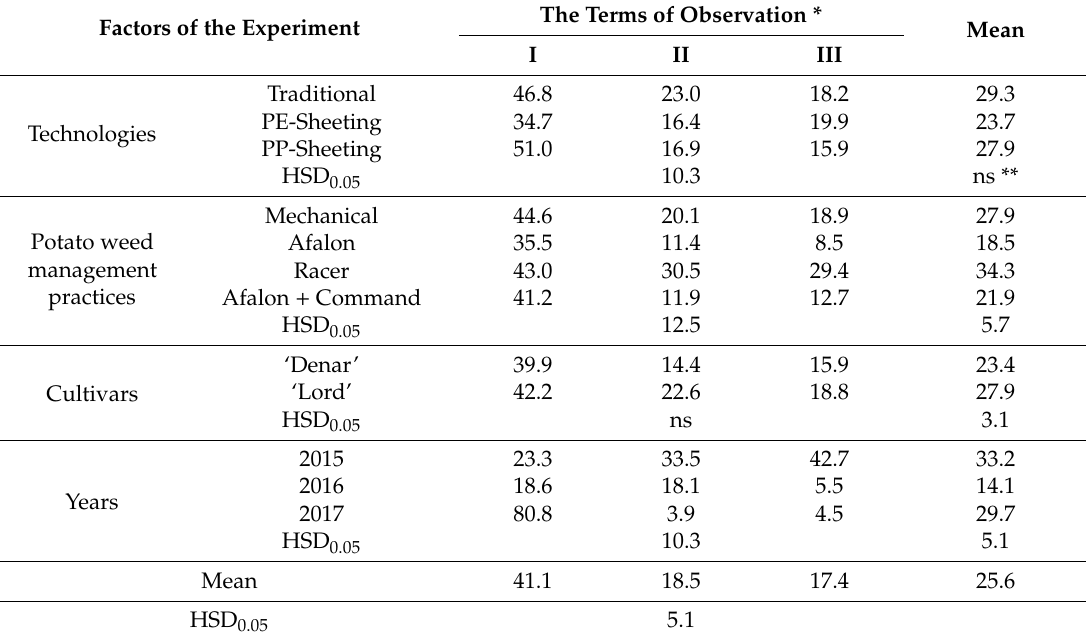
Table 5. The impact of technology, methods of weed management, cultivars, and years of cultivation on the number of monocotyledonous weeds (pcs m − 2